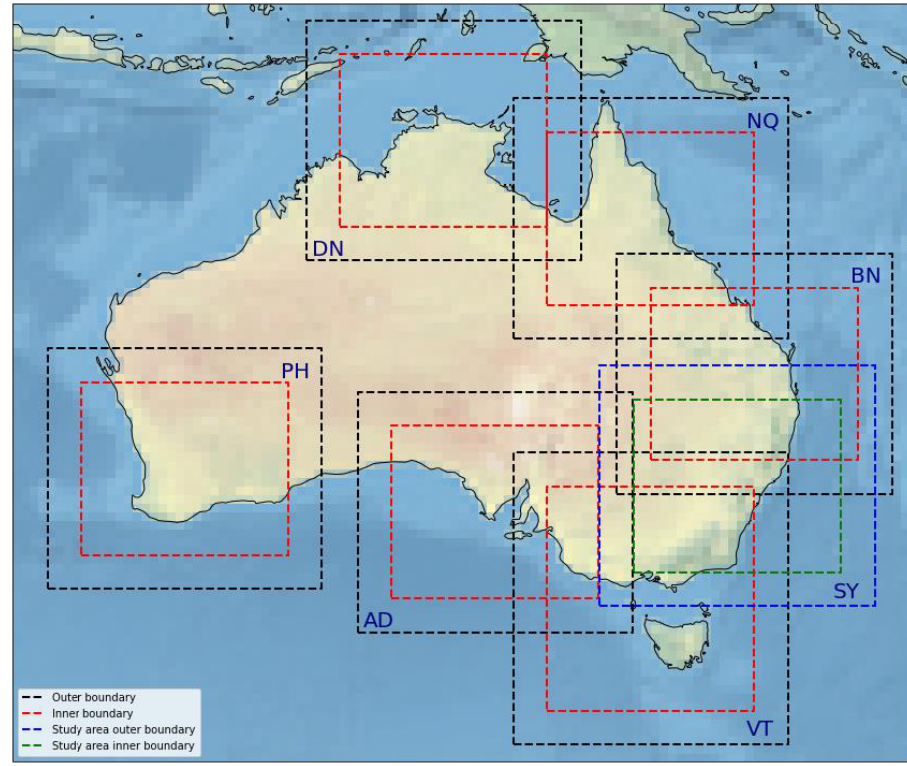
Figure 1. The seven Australian convective-scale variable resolution domains of the Bureau NWP System with the inner and outer grid boundaries (black and red colour). The boundary of the study area (Sydney domain) is shown in different colours (blue and green).